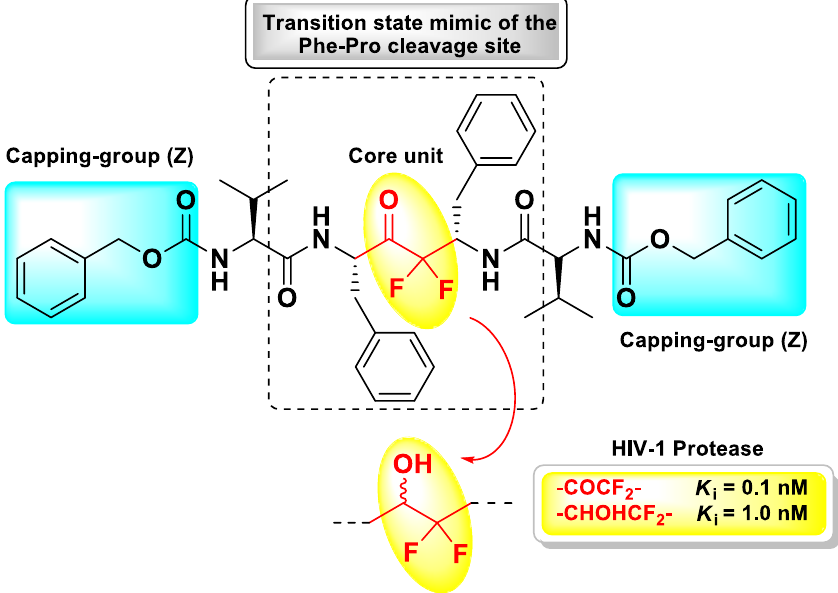
Figure 12. Chemical structure and biological activity of the symmetrical pseudo-peptide developed by Sham H.L. et al. as inhibitor of HIV-1 protease.